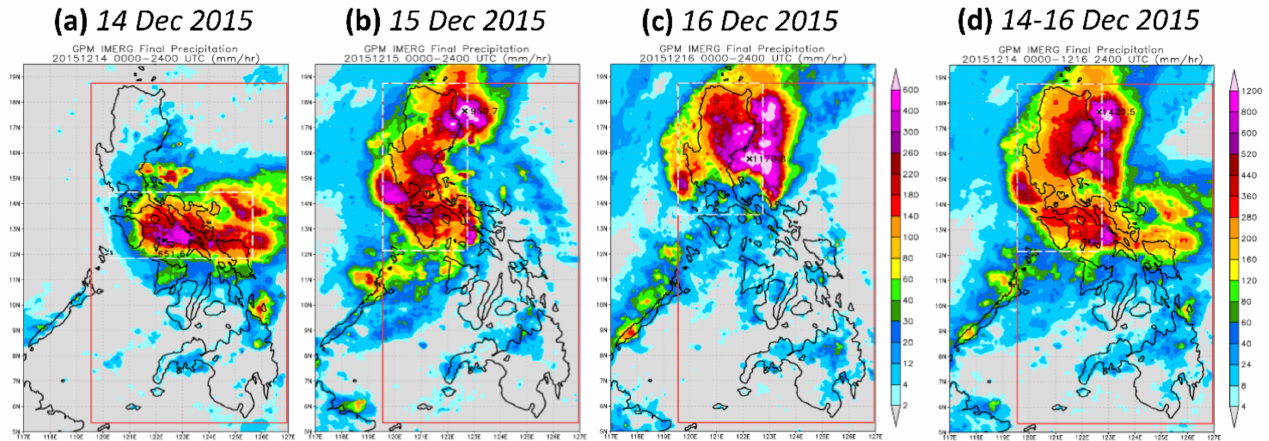
Figure 14. As in Figure 9, except for the GPM IMERG rainfall observation (mm, color) for the 24 h period of ( a ) 14, ( b ) 15, and ( c ) 16 December, and ( d ) for the 72 h period of 14–16 December during TY Melor (2015). All times are in